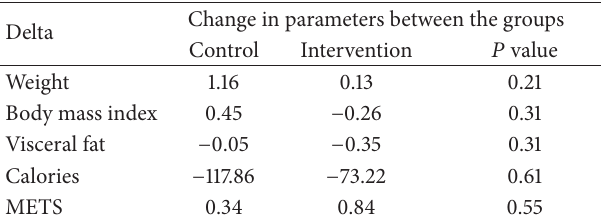
Table 3: Comparison of changes between groups (between group